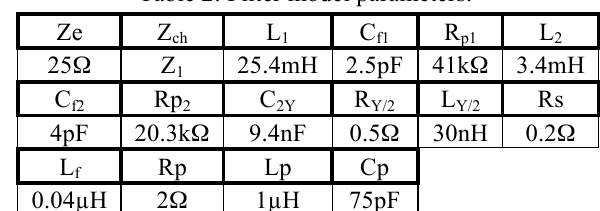
Figure 10: Measured impedance Ze of the LISN.